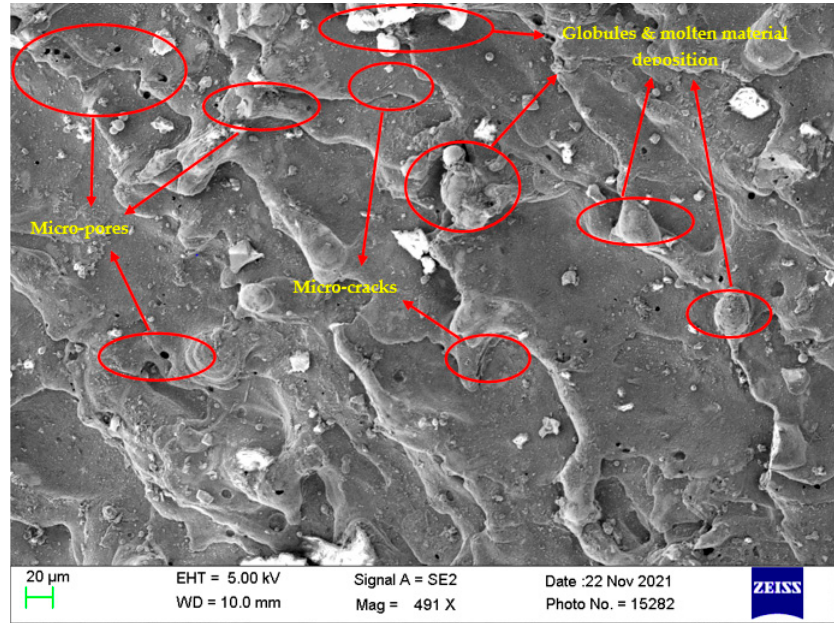
Figure 8. Surface morphology at T on = 31 µs, T off = 12 µs, and Al 2 O 3 amount = 0 g/L.